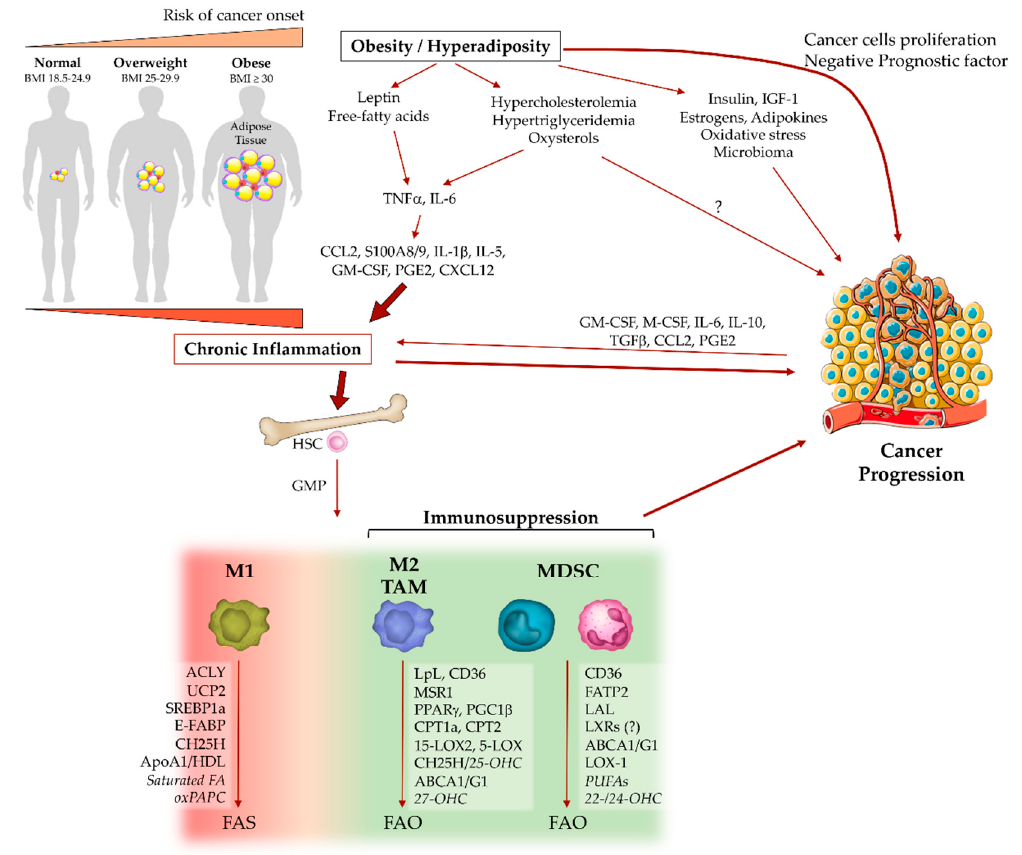
Figure 2. Influence of obesity on cancer-associated inflammation, suppressor myeloid cells and cancer progression. Obesity represents a risk factor for many cancers. Weight gain generates an excess of adipose tissue depots associated with dyslipidemias (i.e., hyper-cholesterolemia and -triglyceridemia) and metabolic alterations (e.g., hyperinsulinemia), which can promote tumor progression. In addition, obesity produces a chronic inflammatory state, which primes myelopoiesis and the immunosuppressive phenotype of tumor-associated myeloid cells. Reprogramming of intracellular lipid metabolism also occurs in myeloid cells from normal-weight cancer bearers in response to TME-derived factors. Several molecular players are associated with either pro- or anti-inflammatory (M1 / M2) states of macrophage activation, as exemplified by tumor-associated macrophages (TAM) and myeloid-derived suppressor cells (MDSC). M1 macrophage polarization activates fatty acid synthesis (FAS), whereas immunosuppressive M2 / TAMs and MDSCs shift toward fatty acid oxidation (FAO). Abbreviations: BMI, body mass index; IGF-1, insulin-like growth factor 1; HSC, hematopoietic stem cell; GMP, granulocyte-macrophage progenitor; ACLY, ATP-citrate lyase; UCP2, uncoupling protein 2; SREBP, sterol regulatory element-binding protein; E-FABP, epidermal fatty acids binding protein; CH25H, cholesterol 25-hydroxylase; ApoA1, apolipoprotein A1; HDL, high-density lipoprotein; FA, fatty acid; oxPAPC, oxidized 1-palmitoyl-2-arachidonyl- sn -glycero-3-phosphorylcholine; LpL, lipoprotein lipase; MSR1, macrophage scavenger receptor 1; PPAR γ , peroxisome proliferator-activated receptor γ ; PGC1 β , PPAR γ coactivator 1 β ; CPT1a / 2, carnitine palmitoyltransferase 1a / 2; 15-LOX2, 15-lipoxygenase 2; 5-LOX, 5-lipoxygenase; ABCA1 / G1, ATP-binding cassette A1 / G1; 22- / 24- / 25- / 27-OHC, 22- / 24- / 25- / 27-hydroxycholesterol; FATP2, fatty acid transport protein 1; LAL, lysosomal acid lipase; LXR, liver X receptor; LOX-1, oxidized low-density lipoprotein receptor 1; PUFA, polyunsaturated fatty acid. Question marks underline controversial or not fully clarified evidence. Words in italics represent lipidic metabolites.